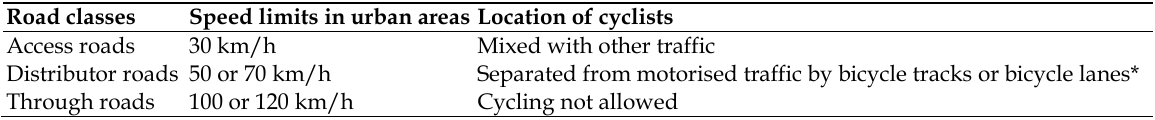
Table 1. Road classification and speed limits in the